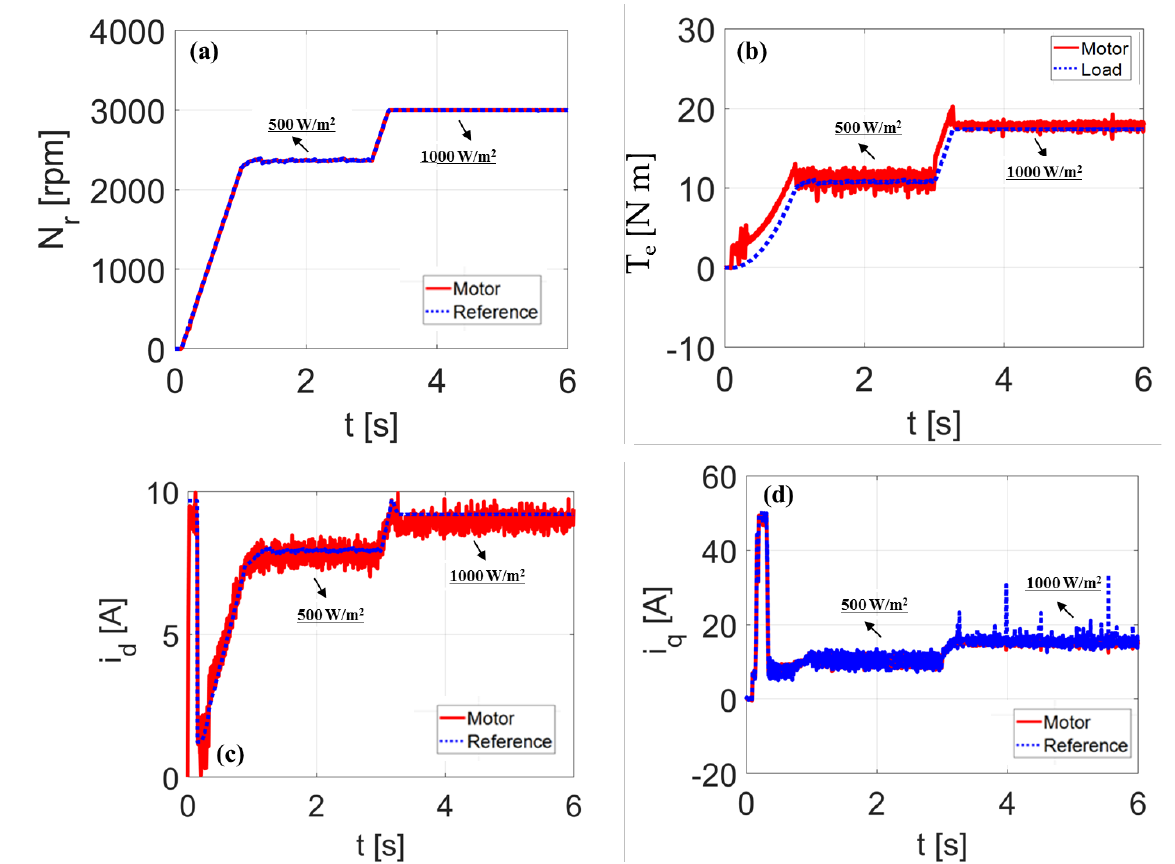
Figure 5. ( a ) SynRM speed versus time; ( b ) SynRM torque versus time; ( c ) SynRM d-axis current versus time; ( d ) SynRM q-axis current versus time.